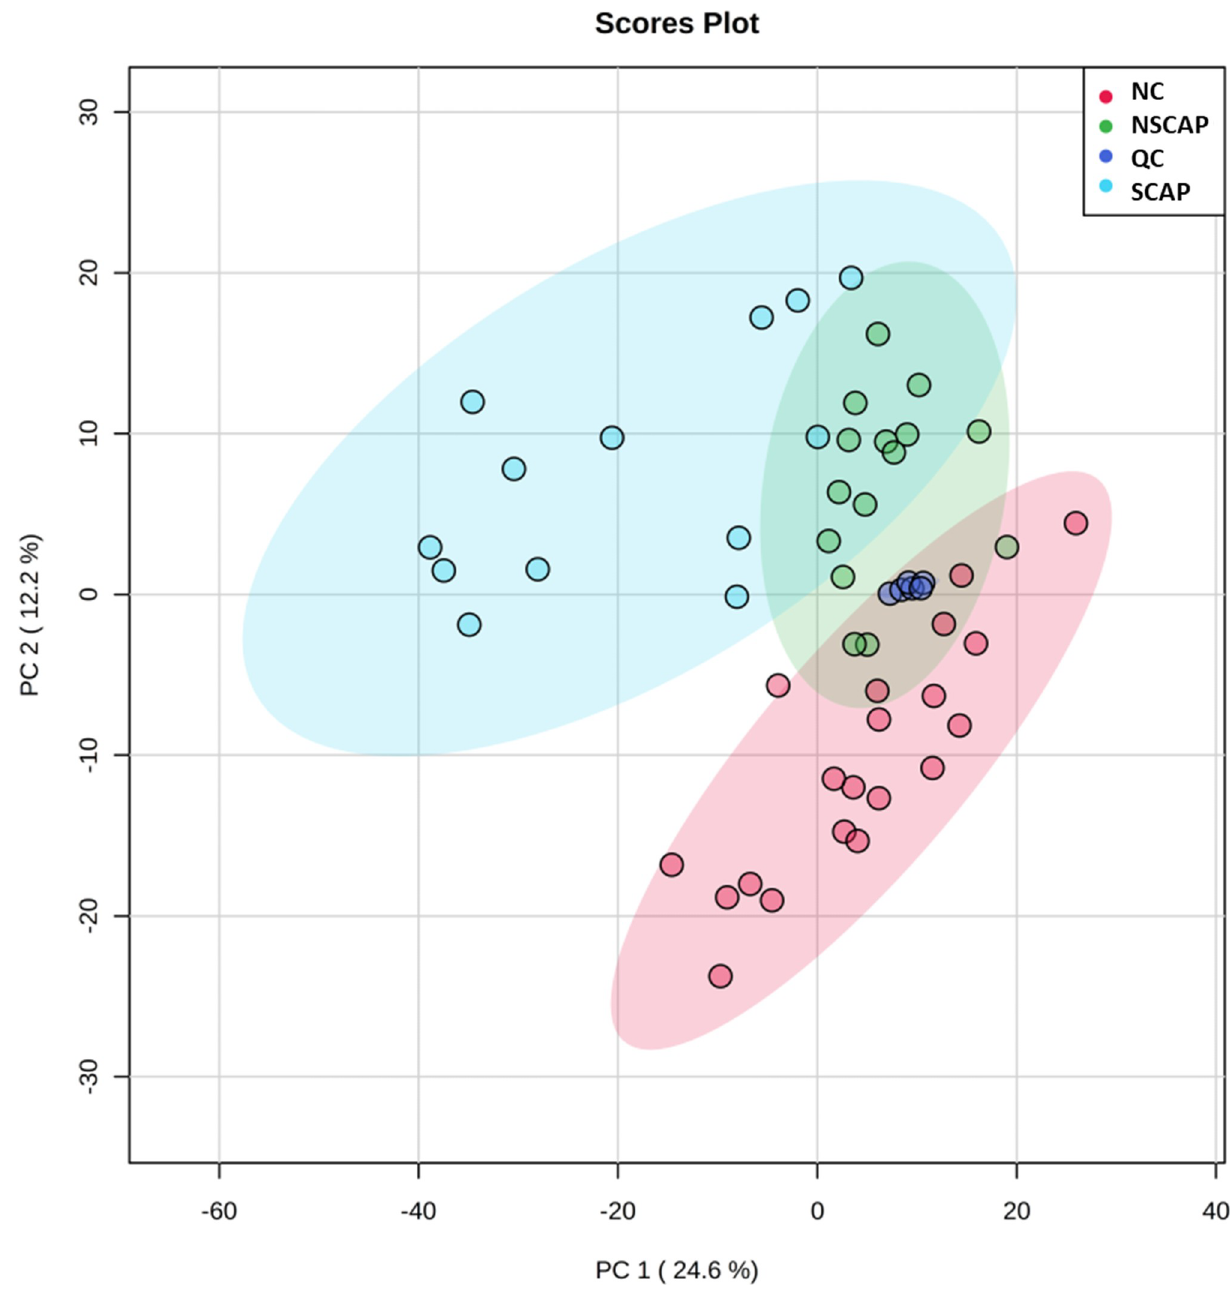
Fig 1. PCA scores plot of lipidomic profiles in CAP group (including NSCAP and SCAP) and NC. Blue, severe CAP (SCAP); Green, non-severe CAP (NSCAP); Red, non-CAP control (NC), Navy blue, quality control (QC) samples; Black, CAP. No sample was placed outside the ellipse that describes the 95% CI of Hotelling’s T-squared distribution. The three groups of lipid profiles can be clearly